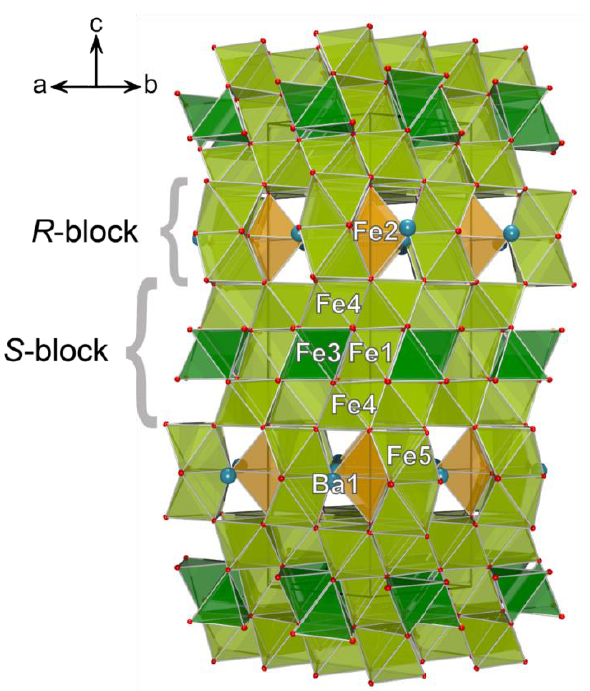
Figure 4. Crystal structure of barioferrite at 100 K. The arrangement of iron-centered polyhedra: octahedral—light green, tetrahedra—dark green, and trigonal bipyramid—orange, and the blue spheres represent Ba.